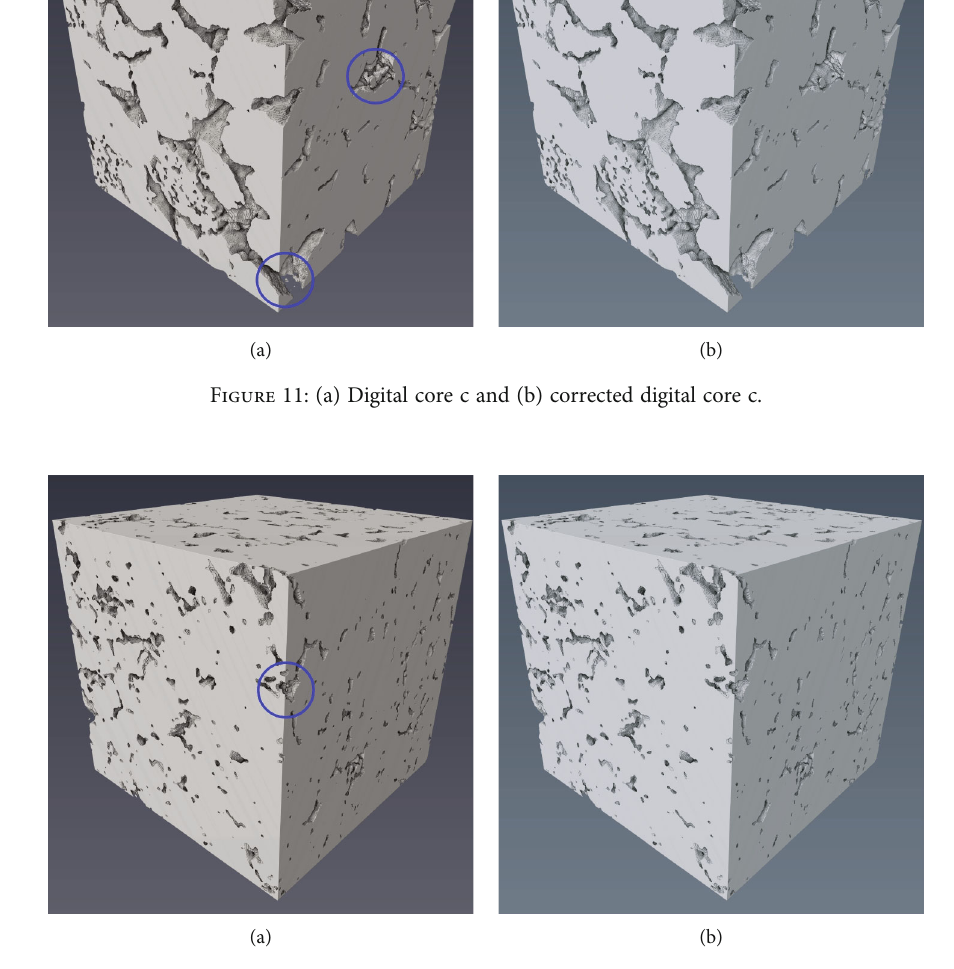
Figure 12: (a) Digital core d and (b) corrected digital core